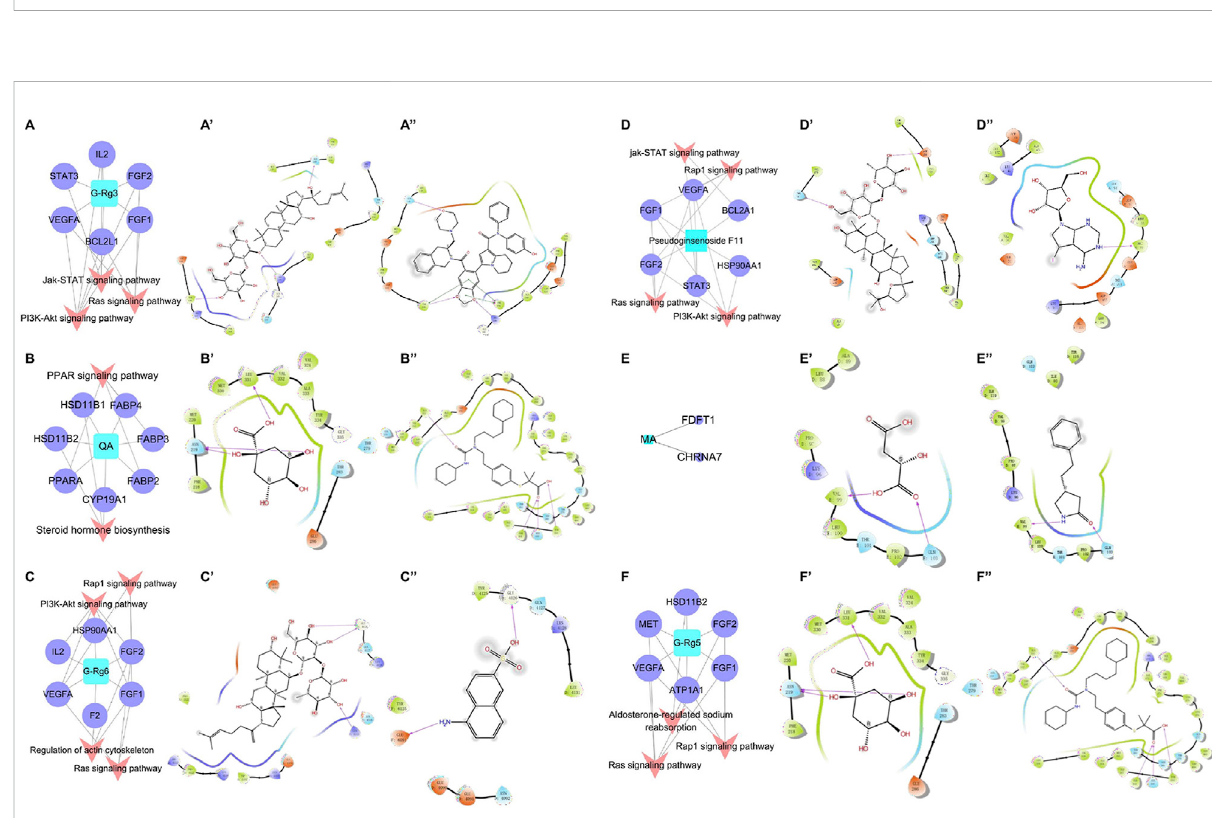
FIGURE 4 Validation of the anti-heart failure activity of ginsenoside Rg3, ginsenoside Rg5, ginsenoside Rg6, malic acid, L-argininosuccinic acid, quinic acid, and pseudoginsenoside F11. (A – G) Statistical results of the pericardial area of the zebra fi sh. n = 10; (A ’– G ’ ) statistical results of the venous congestionareaoftheheartinzebra fi sh. n =10; (A ” – G ” ) statisticalresultsoftheSV – BAdistanceinzebra fi shhearts. n =10.## p < 0.01vs.thecontrol group,* p < 0.05 and ** p < 0.01 vs. the model group.